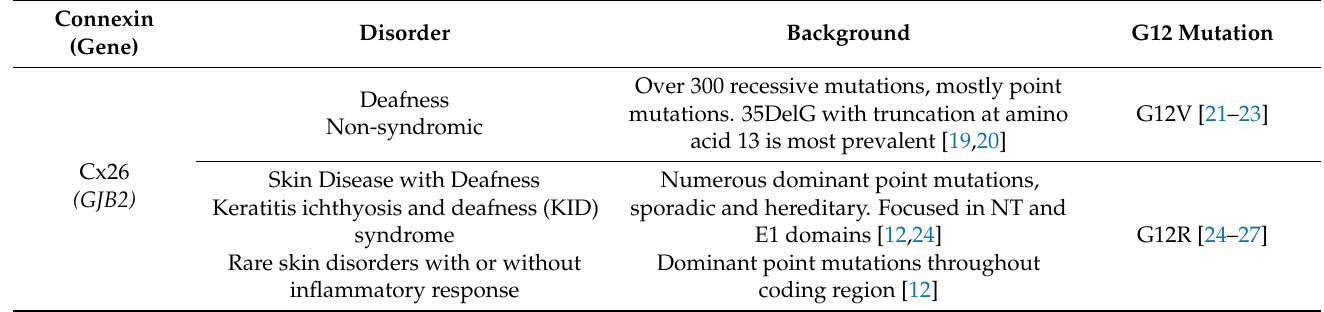
Table 1. Hereditary Disorders Associated with G12 Mutations in